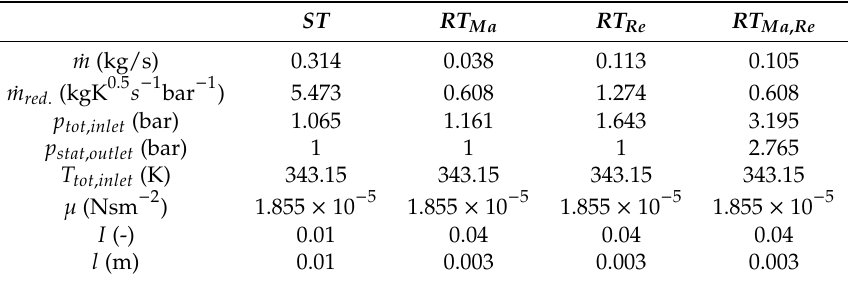
Table 2. Boundary